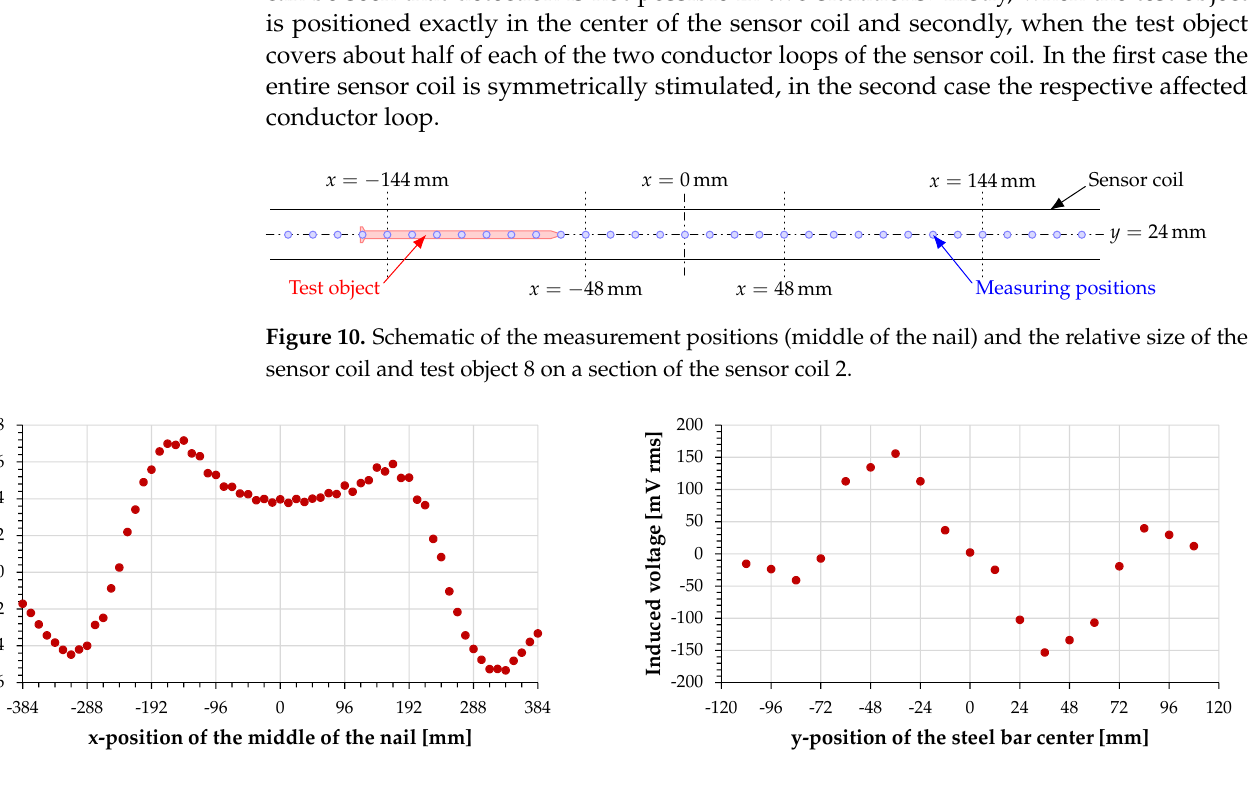
Figure 11. Calculated influence of the test objects 7 and 8 on sensor coil 2 as a function of the position of the test objects taking into account offset voltage and phase angle ( left ) Test object 8 ( right ) Test object 7.